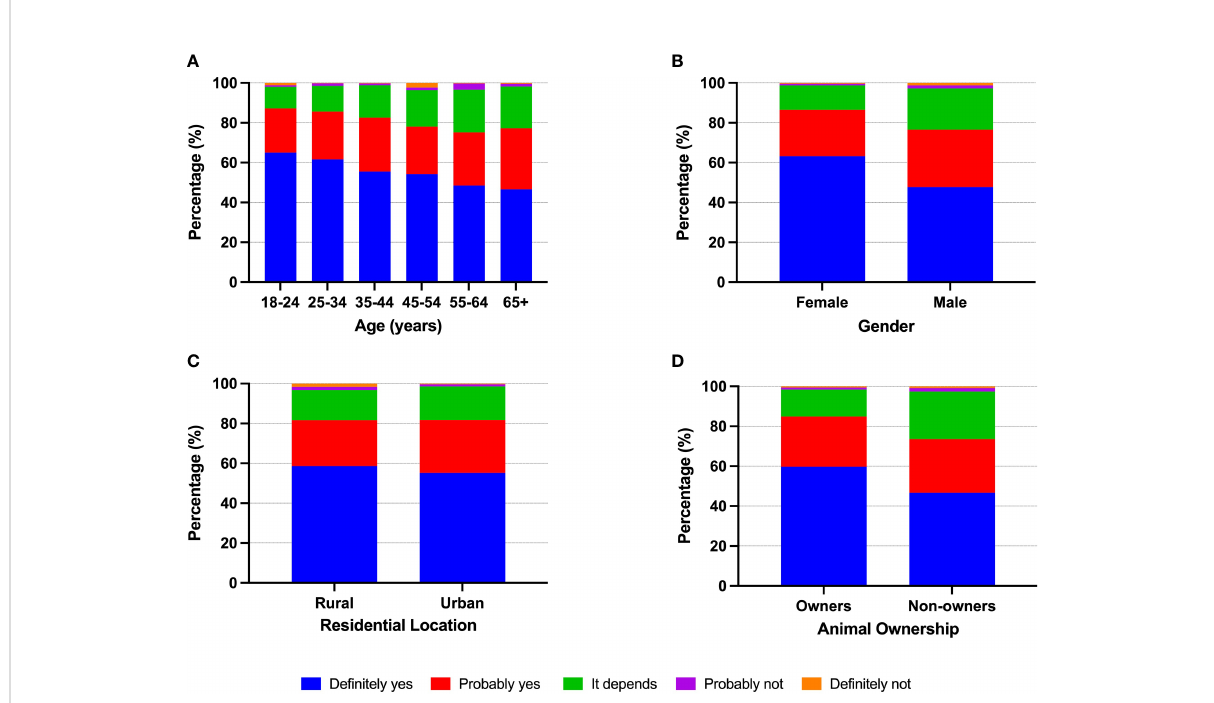
FIGURE 7 Percentages showing the signi fi cant relationship between opinion on prosecution rates and the demographic variables of age (A) , gender (B) , residential location (C) and animal ownership (D) ; p-value < 0.05. “ In your opinion do you think more animal welfare investigations should go to court? ” based on a 0.6% prosecution rate from 2019/2020 fi nancial year